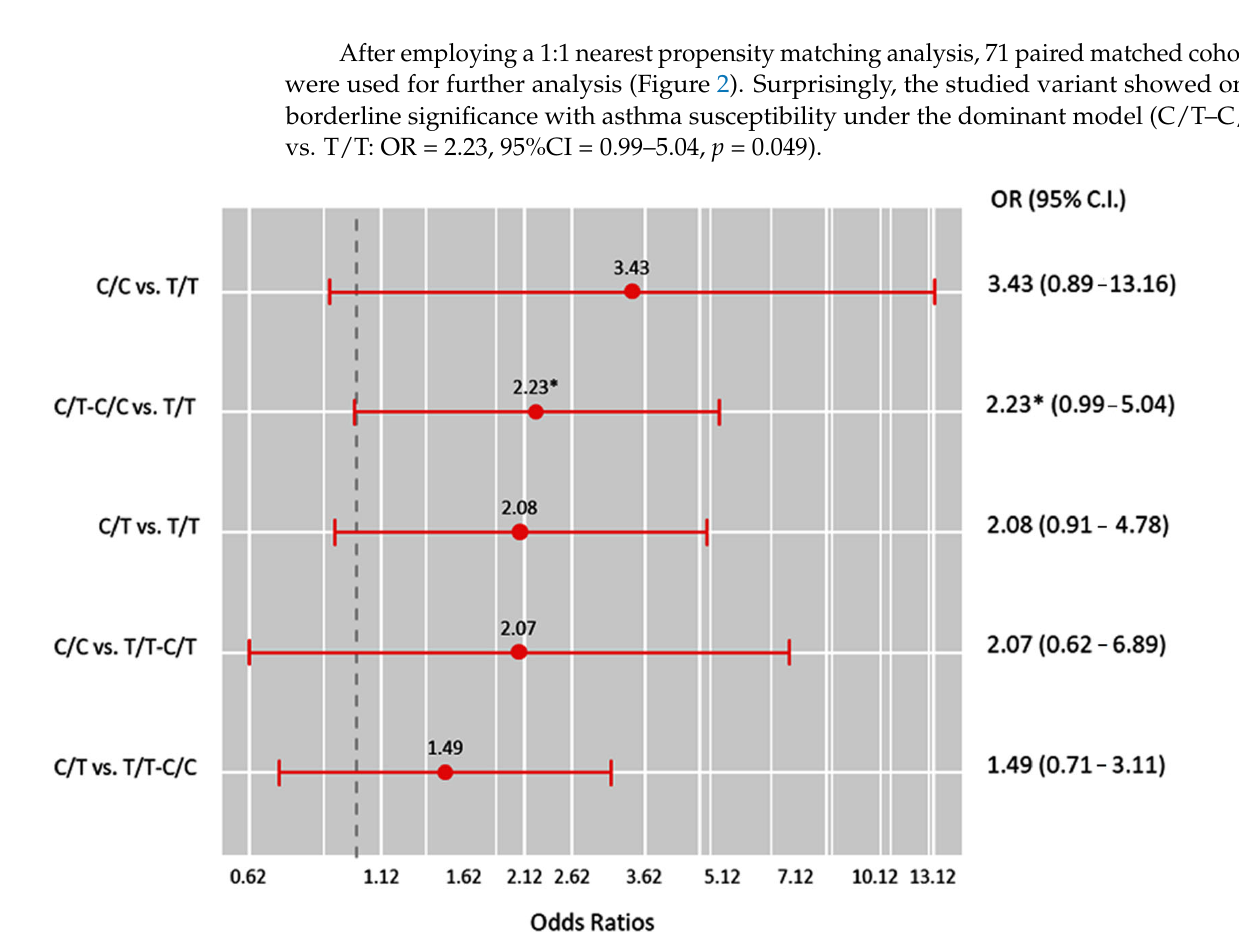
Table 4. Association of HSPA1A genotypes with demographic and clinicolaboratory data in patients with BA (N = 71 patients). Characteristics